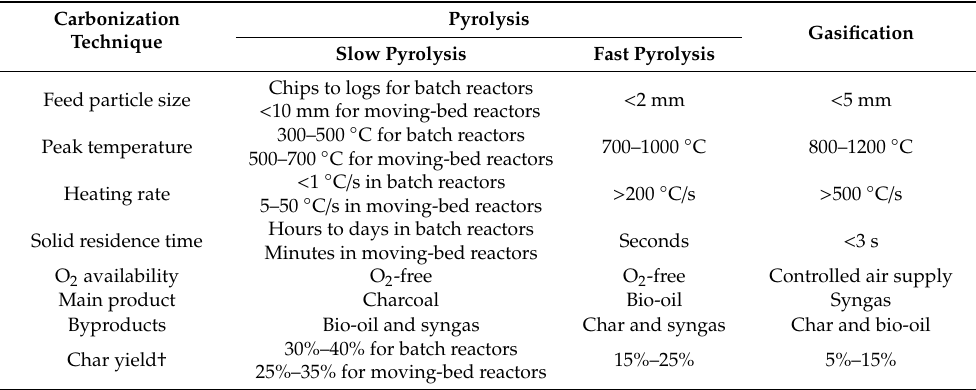
Table 2. The carbonization conditions for thermochemically processing biomass residues using pyrolysis and gasification techniques